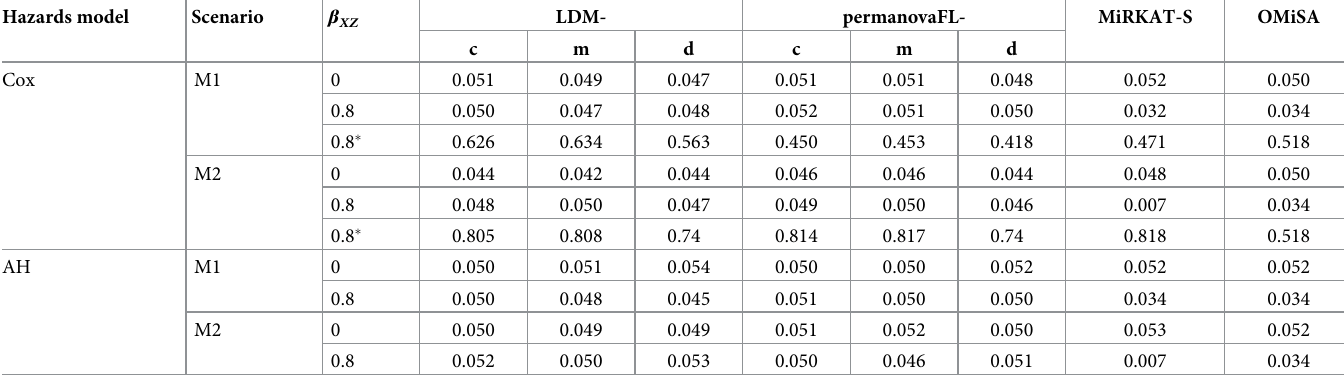
Table 1. Type I error of the global tests for simulated data with 50% censoring and n = 100. Hazards model